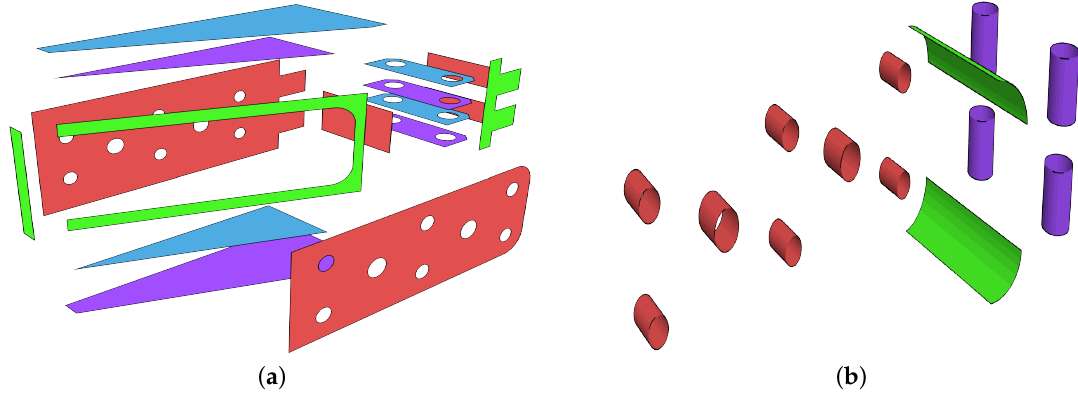
Figure 5. Decomposition of the model from Figure 2 into ( a ) planar primitives and ( b ) cylindrical